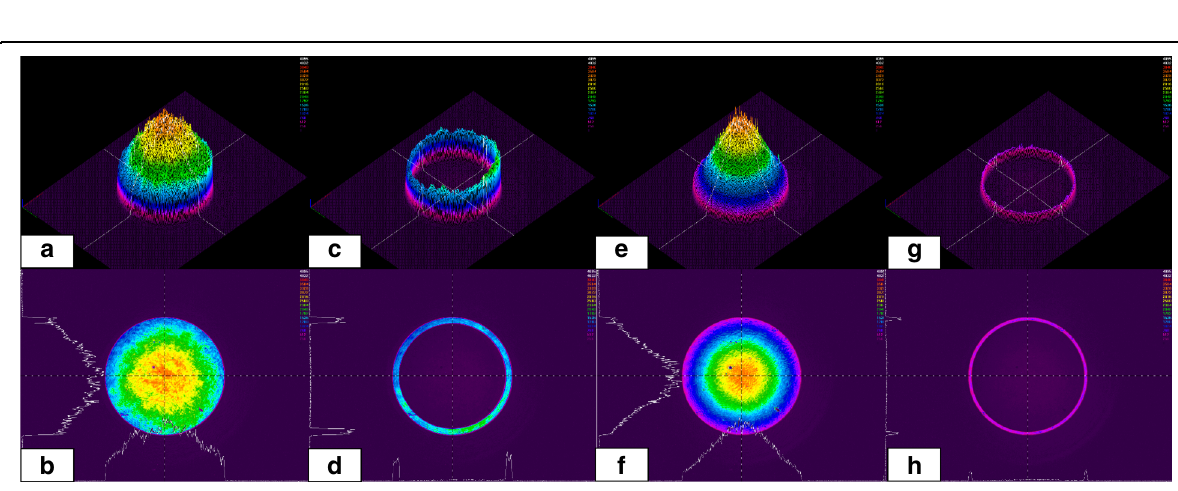
Beam intensity distribution modulation To obtain a high-quality and high-purity longitudinal fi eld, not only the spherical aberration needs to be removed, but also the intensity distribution needs to be